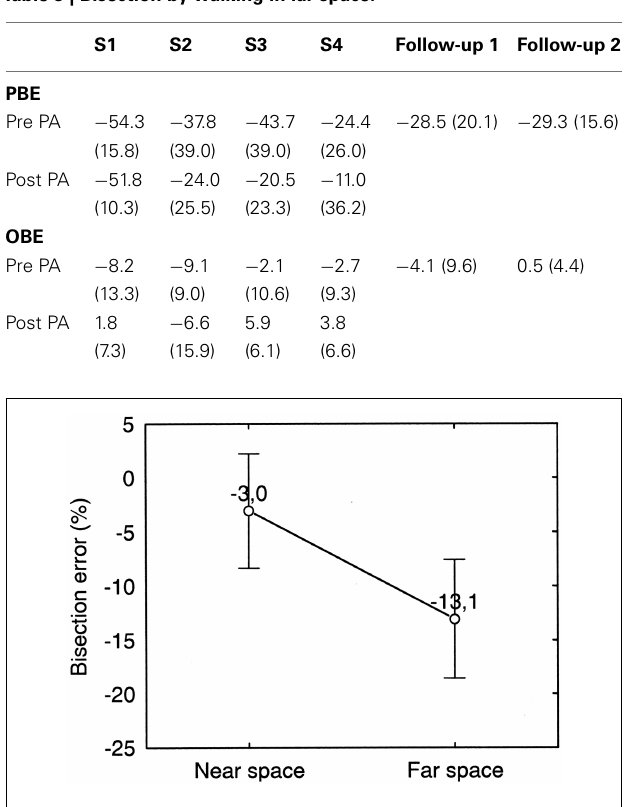
FIGURE 6 | Near and far space bisection errors of patient MR in the manual bisection task . Error bars represent standard errors. Bisection error is expressed as % deviation with respect to half line length. Negative and positive values indicate errors to the left and to the right of the objective midline, respectively.The error is to the left of the true center of the line and is significantly larger in far space than in near